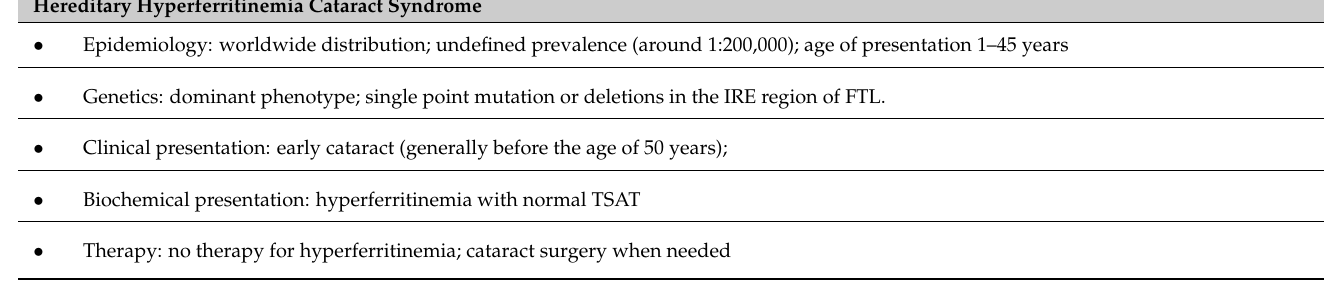
Table 2. Epidemiology, genetics, most relevant clinical and biochemical characteristics, and therapeu- tical approach in inherited isolated